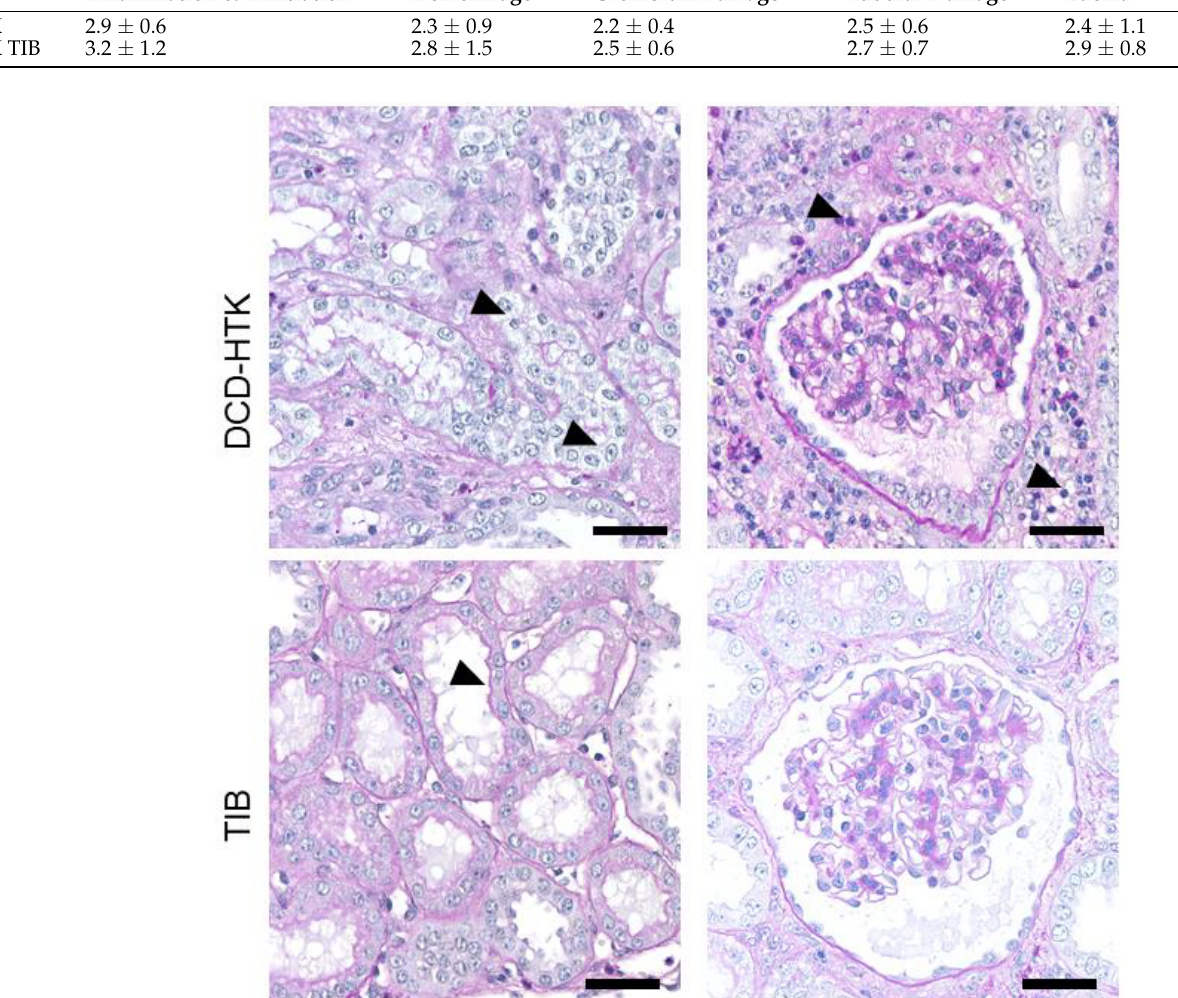
Figure 5. Histological appearance of kidneys 7 days after transplantation in PAS staining in the DCD HTK ( above ) and HTK TIB group ( below ). Black arrows show tubular damage (loss of villi and edema, respectively) in column 1, in column 2 marking of immune cells. Magnification 200×, Scale bars 20 µm.